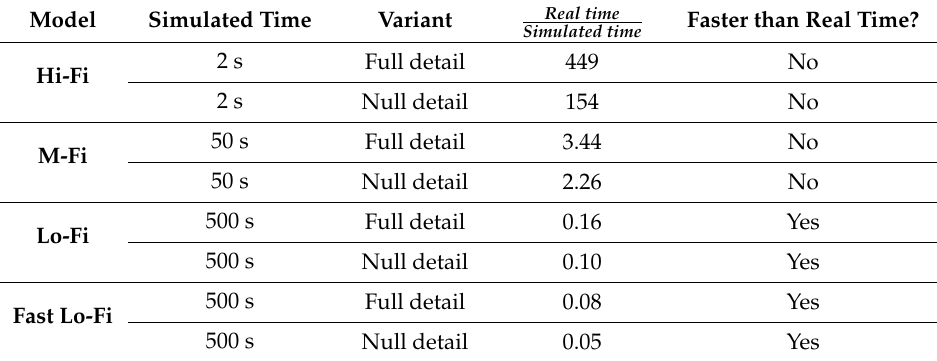
Table 7. Speed comparison of the electrical models where the relation between the real time and the simulated time is shown. Model Simulated Time